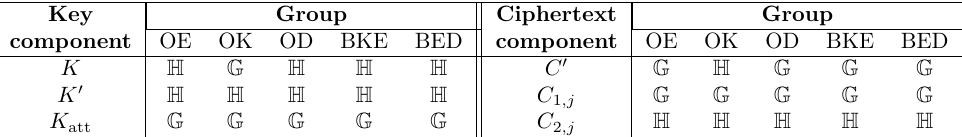
Table 4: The distributions of the key and ciphertext components of Wat11-IV over the groups G and H , for each optimization